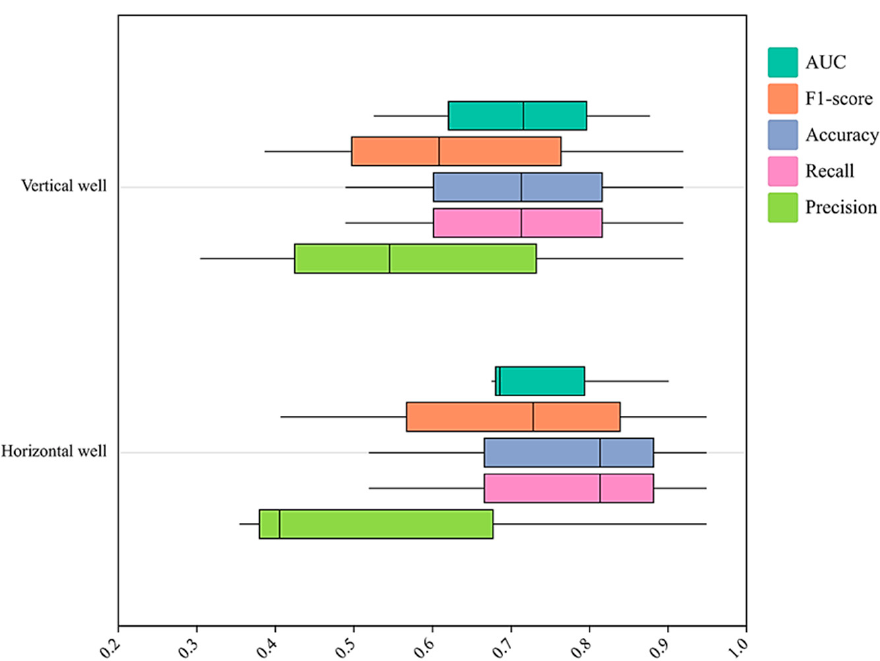
Figure 12. Overall performance of the random forest algorithm in vertical and horizontal wells. No matter vertical well or horizontal well, the accuracy of the optimized random forest algorithm is very high. At the same time, it also proves that the random forest algorithm is applicable to the production profiling of vertical wells and horizontal wells.